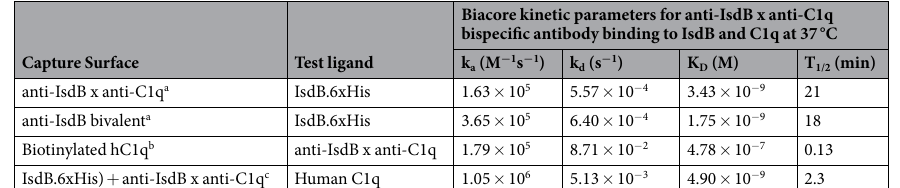
Biacore kinetic parameters for anti-IsdB x anti-C1q bispecific antibody binding to IsdB and C1q at 37 °C